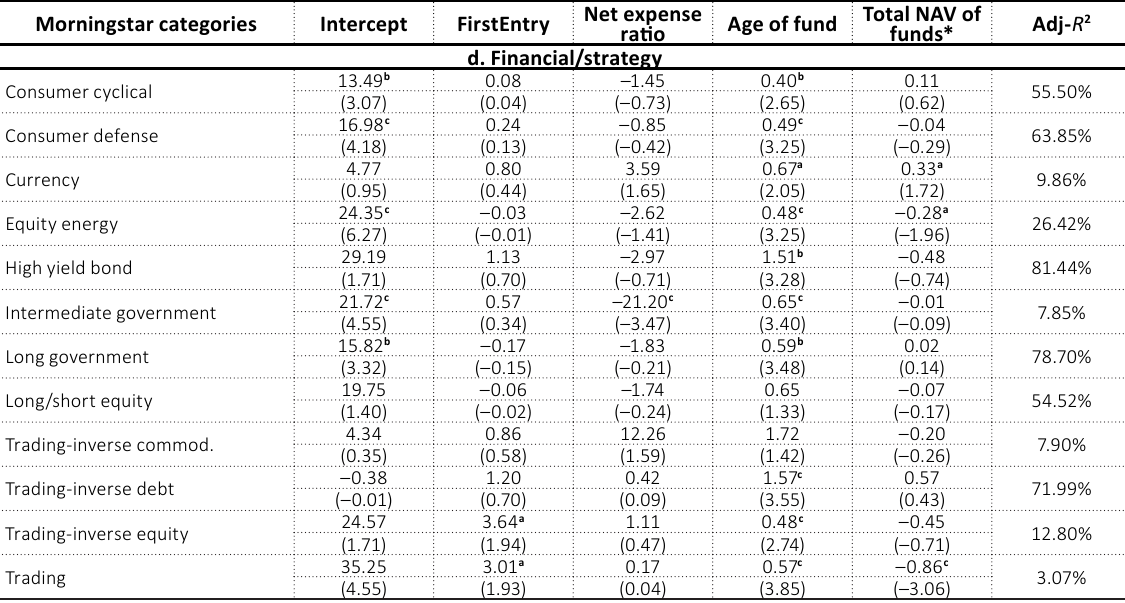
Table 4 (cont.). Regression of net asset value (NAV) on FirstEntry, net expense ratio, age of fund, total NAV of fund